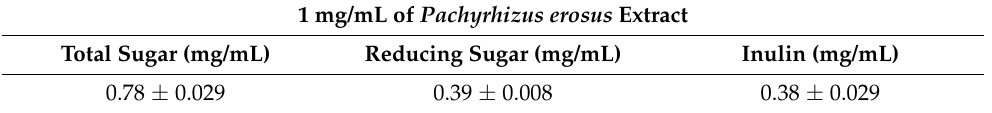
Table 1. The content of